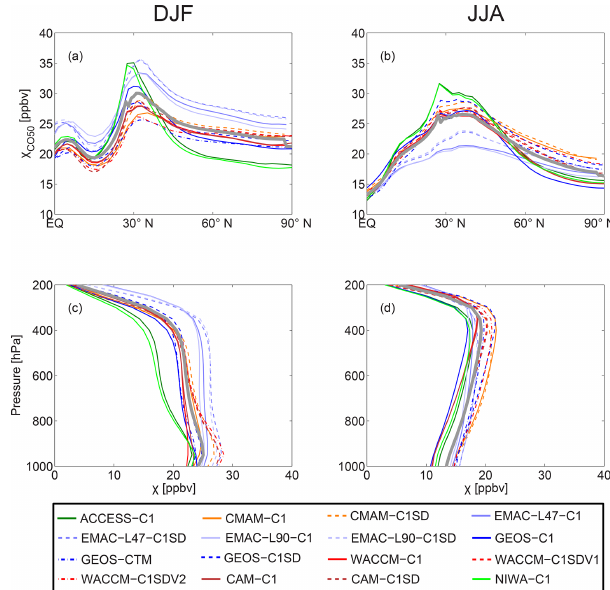
Figure 2. (a, b) Latitudinal and (c, d) vertical variations in zonal- mean CO50 concentration χ CO50 (units: ppbv) for each model dur- ing (a, c) DJF and (b, d) JJA. The corresponding ensemble means are depicted as the heavy gray lines. In (a) and (b) , χ CO50 values are averaged in the middle and lower troposphere (500–800hPa); whereas in (c) and (d) , χ CO50 values are averaged over the Arctic (70–90 ◦ N). Note that C1 simulations are shown as solid lines while C1SD simulations are shown as dashed or dotted–dashed